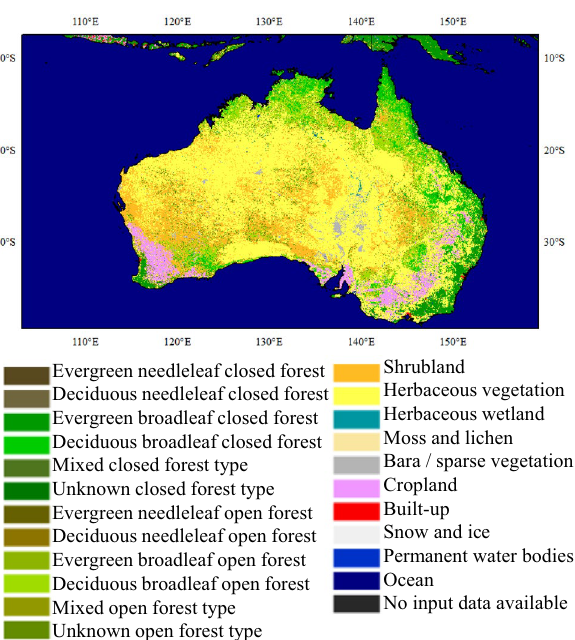
Figure 11. Land cover map of hotspot-2 (Australia). This figure was generated using ArcGIS version 10.1 (https:// www. esri. com/ en- us/ home). Shape for countries of the world downloaded from Geografía, SIG y Cartografía Digital. (http:// tapiq uen- sig. jimdo free. com). The land cover data was from Buchhorn et al. 32 (https:// land. coper nicus. eu/ global/ produ cts/